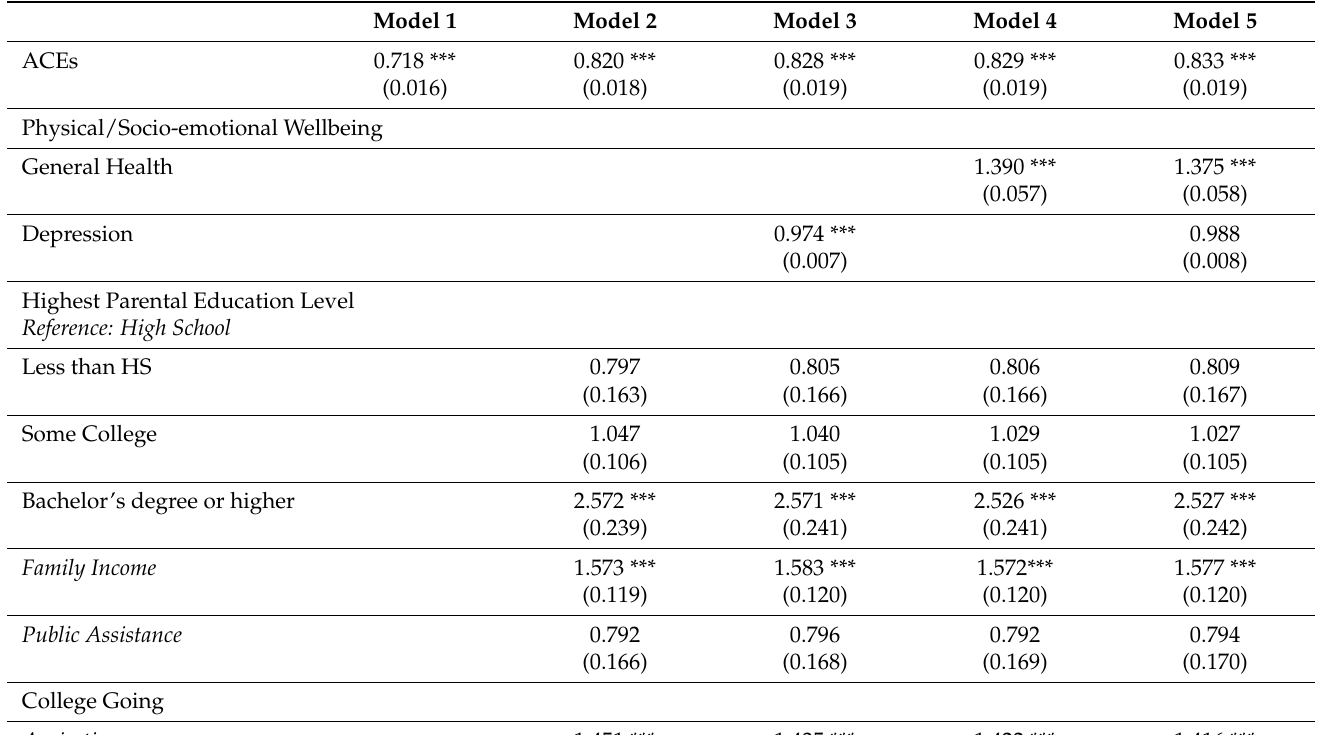
Table 2. Logistic regression (odds ratio) results of timely BA/BS attainment by